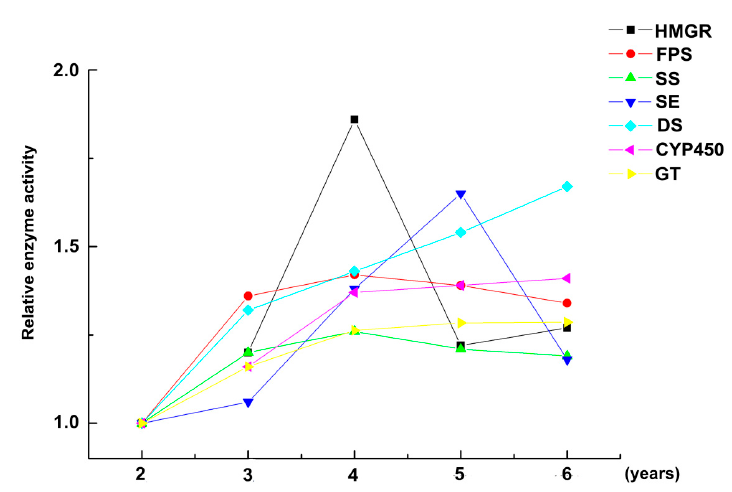
Figure 5. The changes in relative enzyme activity in fresh ginseng roots after different years of growth. (Enzyme activity at two years of growth was the control group, n = 60 ginseng).